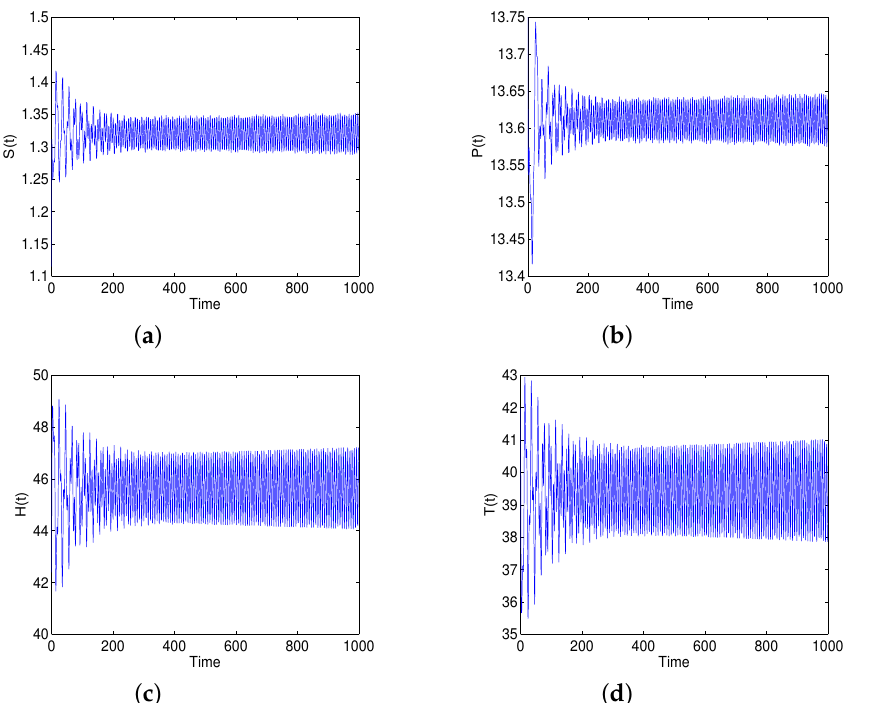
Figure 8. The time of ( a ) susceptible population, ( b ) psychological addicts, ( c ) physiological addicts and ( d ) drug-users in treatment plot for τ 2 = 9.3825 > τ 2 ∗ = 8.9875 and τ 1 = 1.5 ∈ ( 0, τ 10 ) with A = 2, d = 0.02, β 1 = 0.016, β 2 = 0.028, π = 0.03, γ = 0.095, θ = 0.5 and σ =